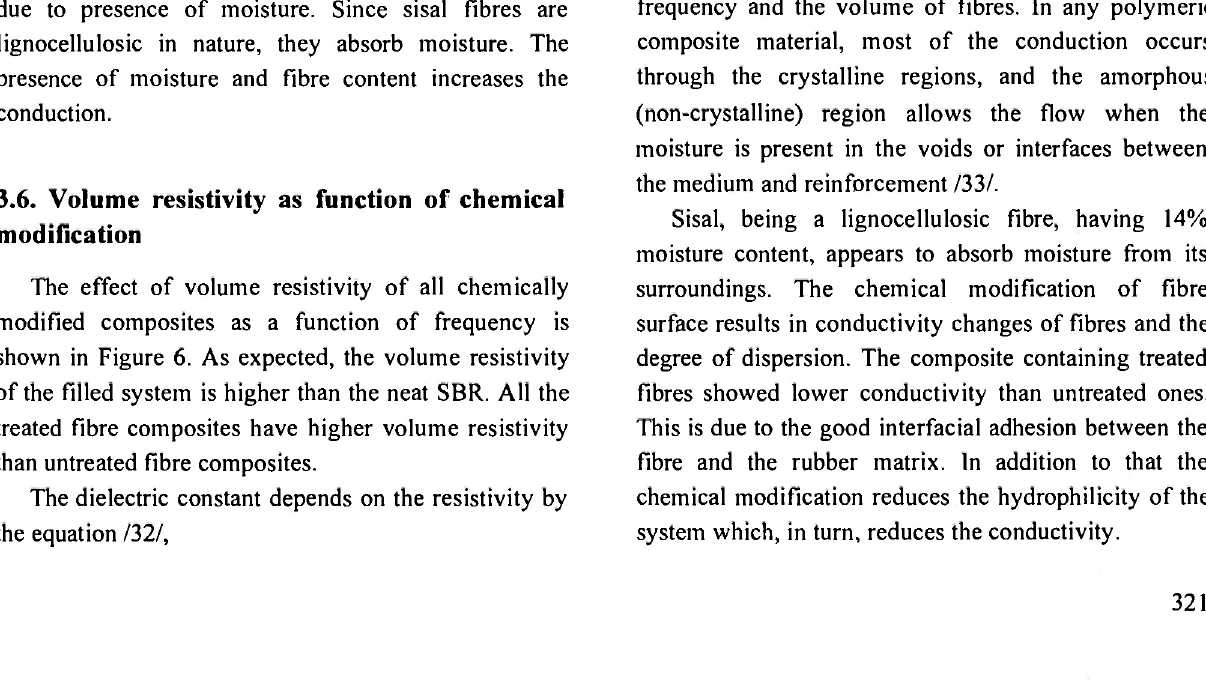
Fig. 6: Effect of various chemical modifications of fibres on the volume resistivity of composites as a function of